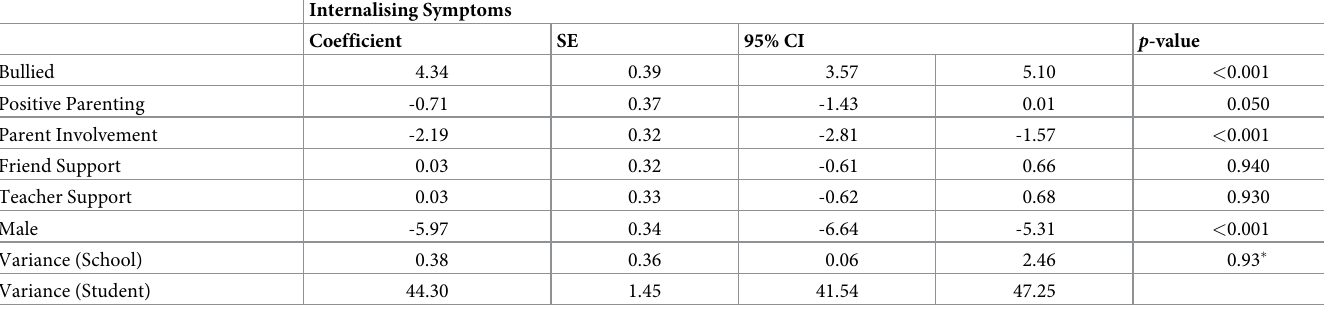
Table 8. Linear mixed-effects models of bullied once per week & all sources of social support (weighted). Internalising Symptoms